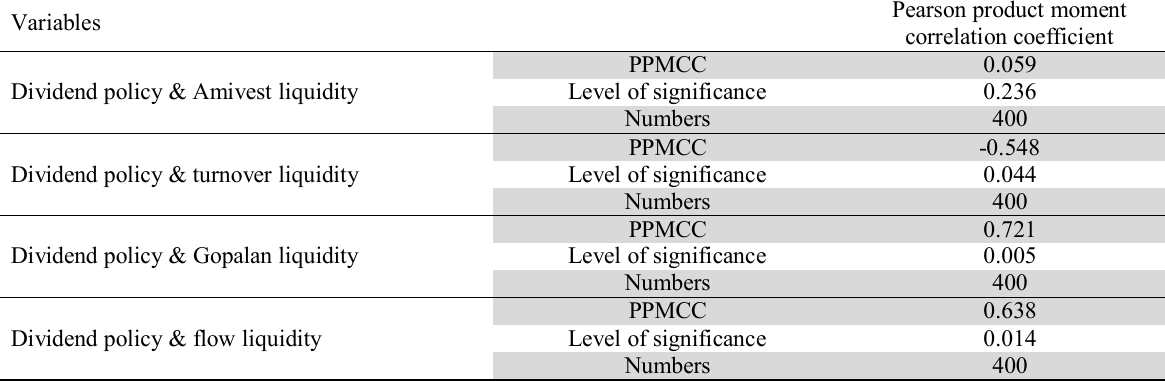
The Results of correlation Analysis for Research